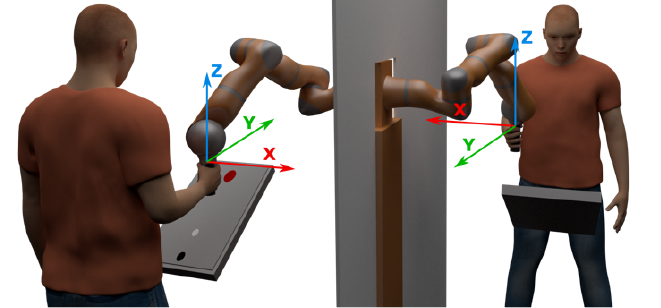
Figure 1. Experimental setup of the study. The graphic user interface (GUI) can be seen on the screen in front of the left subject. The GUI displays the starting point (black), target point (red), and the controlled point (white) in real